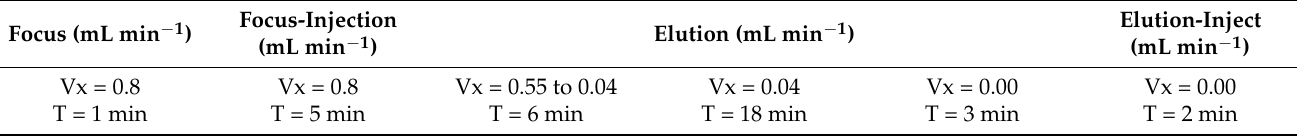
Table 2. Flow conditions for the HF5